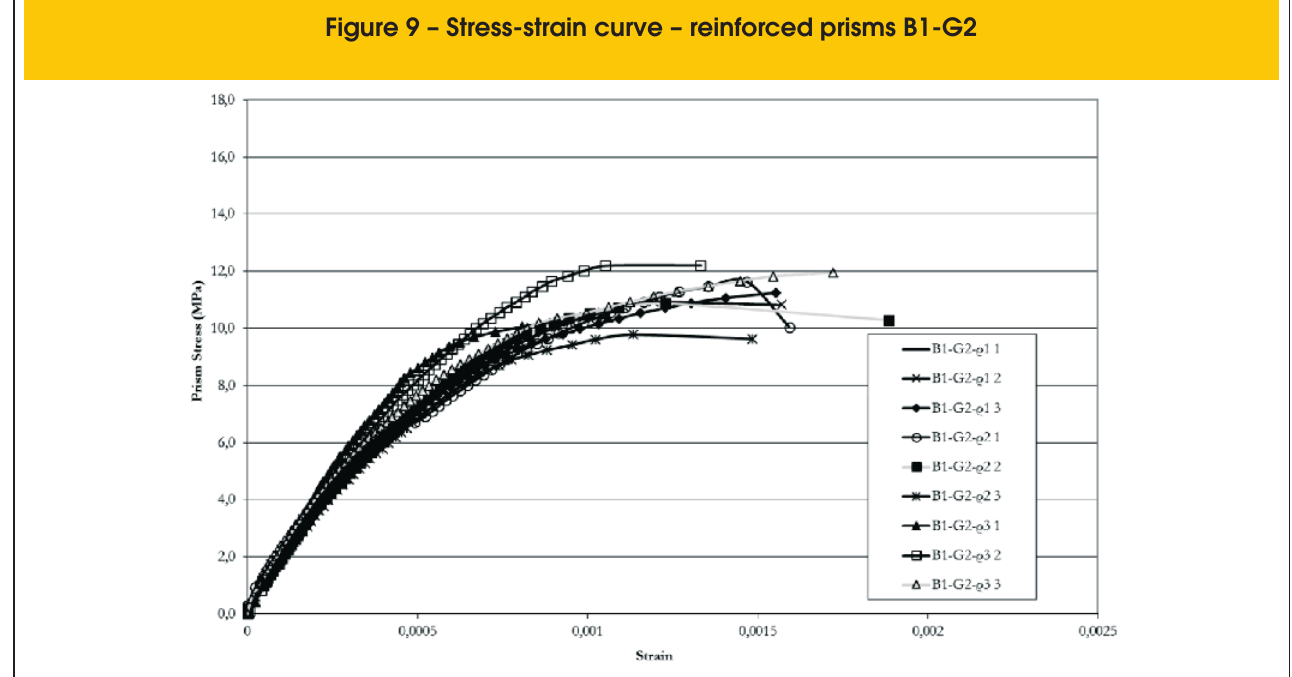
Figure 9 – Stress-strain curve – reinforced prisms